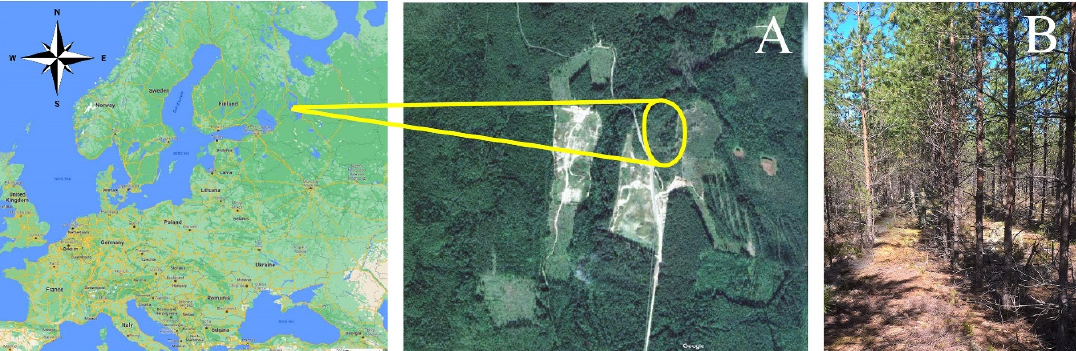
Figure 1. Geographic location of the study sites in the Karelia Republic, Russian Federation ( A ); 16-year-old Scots pine crops ( B ).